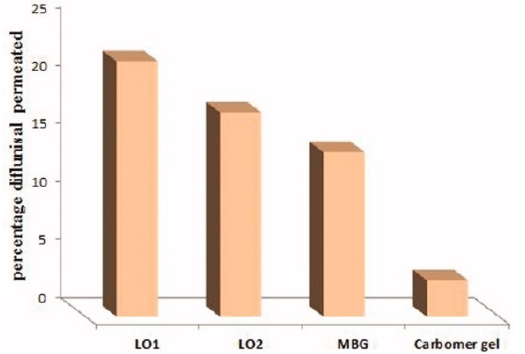
Figure 9. Percentage diflunisal permeated through human skin from lipogels (LO1 and LO2), mi- croemulsion-based hydrogel (MBG), and carbomer gel after 24 h. MBG—microemulsion-based hy- drogel form; LO1—organogel based on Lipoid S75; LO2—organogel based on Phospholipoin 85 G. Reproduced from [36], with permission from Taylor & Francis, 2021.